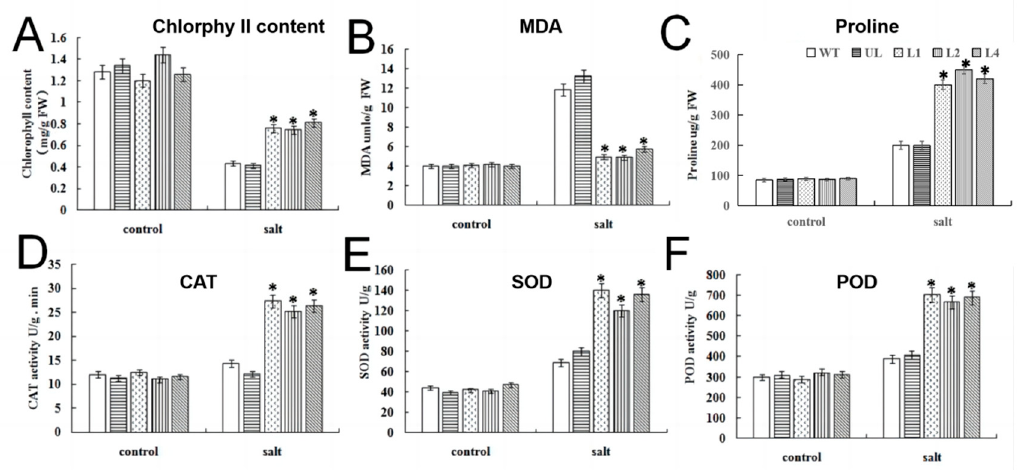
Figure 6. Effects of salt stress on physiological and biochemical indexes of FvMYB114 transgenic lines. After being treated with 200 mM NaCl for 7 days, the contents of ( A ) chlorophyll, ( B ) MDA and ( C ) proline and the activities of ( D ) CAT, ( E ) SOD and ( F ) POD in WT, UL, L1, L2 and L4 were determined. An asterisk marks the SD between transgenic lines and WT (* p ≤ 0.05). The control group set the level of each index in the WT.